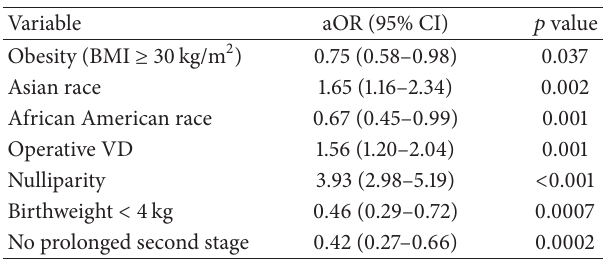
Table 2: Multivariate logistic regression for predicting risk of